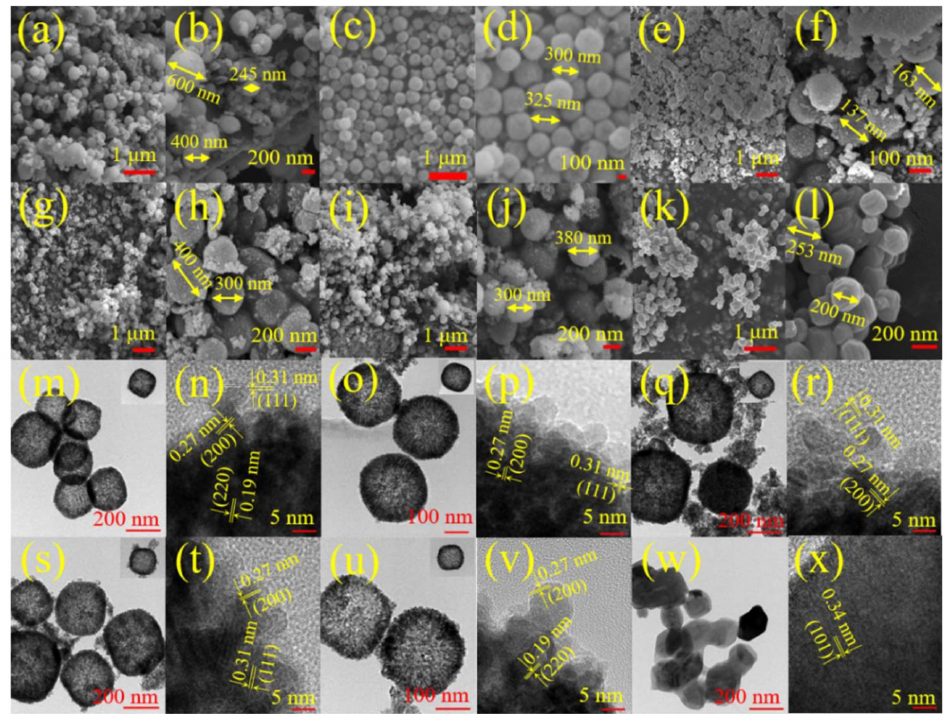
Figure 2. Field emission scanning electron microscopy (FE–SEM) images of ( a , b ) CeO 2 , ( c , d ) V 0.025 Ce, ( e , f ) V 0.05 Ce, ( g , h ) V 0.1 Ce, ( i , j ) V 0.2 Ce, and ( k , l ) VO x ; high-resolution transmission electron mi- croscopy (HR–TEM) patterns of ( m , n ) CeO 2 , ( o , p ) V 0.025 Ce, ( q , r ) V 0.05 Ce, ( s , t ) V 0.1 Ce, ( u , v ) V 0.2 Ce, and ( w , x ) VO x .